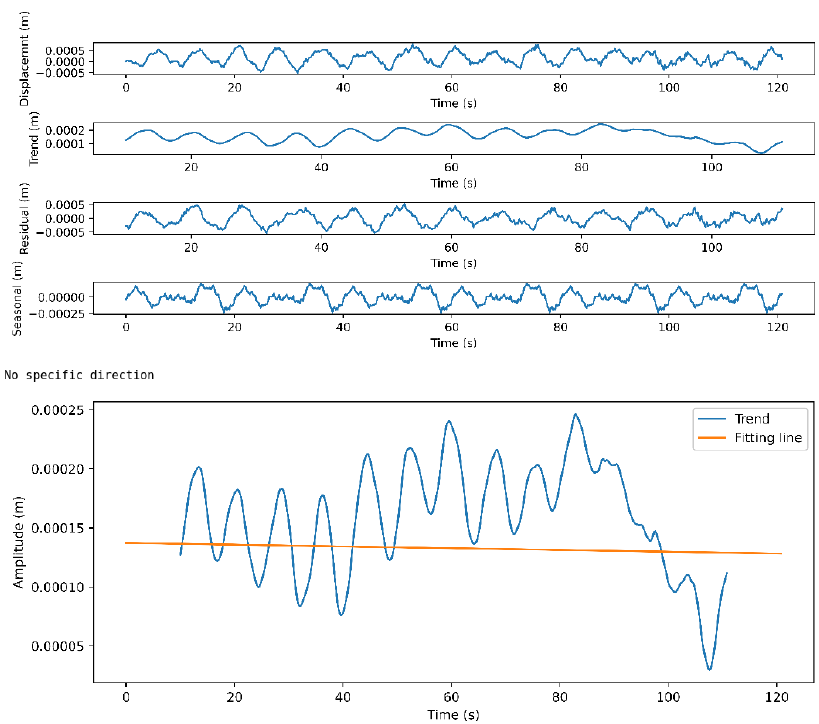
Figure 12. Full body up/down movement analysis for a professional meditator.